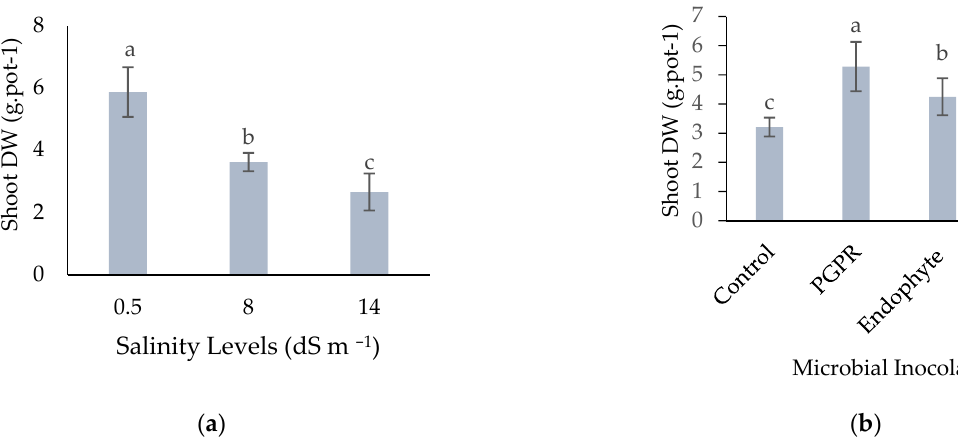
Figure 5. The effect of ( a ) salinity levels and ( b ) microbial inoculation on shoot dry weight. Bars show the means ± standard error of the mean. Means with a different letters indicate significantly different values at p < 0.05 based on Duncan’s multiple range test.